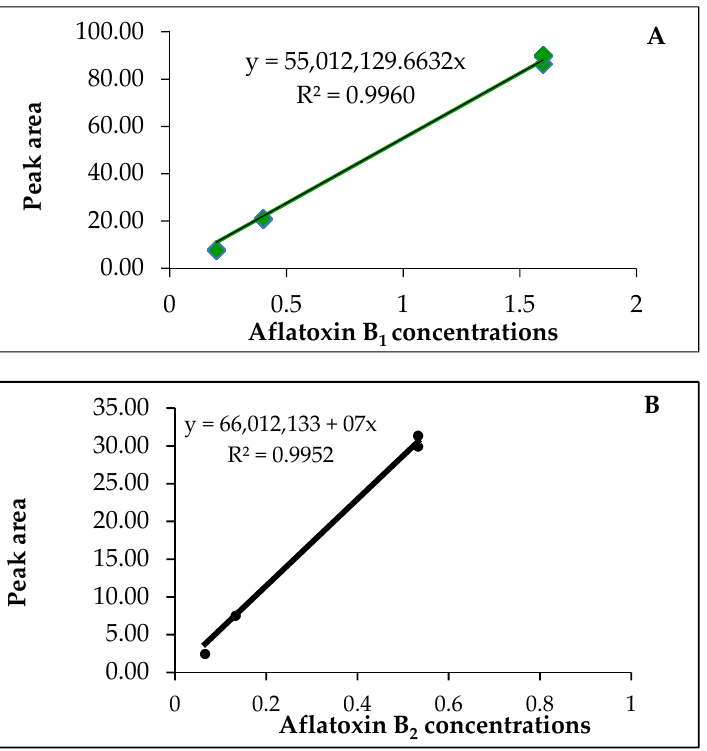
Table 1. Validation of the quantification of AFs by HPLC.